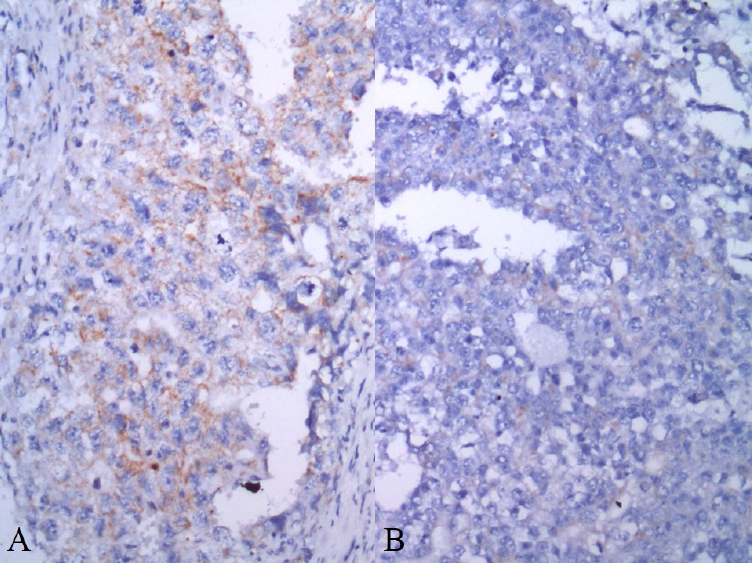
Figure 6. High ( A ) and low ( B ) AIF expression in two different samples of embryonal carcinoma (immunoperoxidase